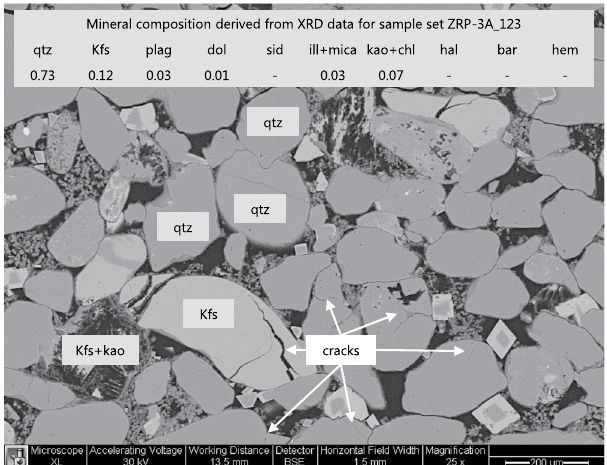
Figure 5. BSEM image of sample ZRP-3A_123BV, showing a representative microstructure of a sandstone sample in the post-testing state with a mean grain size of 140 µ m (obtained by Laser particle size analysis). Top part of the image lists the mineral content derived from X-Ray Diffraction analysis using bulk rock material. The image shows multiple examples of leached K-feldspar (grain skeletons), in which also kaolinite is present as reaction product of the leaching product. Quartz minerals contain cracks, as well as grain rimming clay minerals.